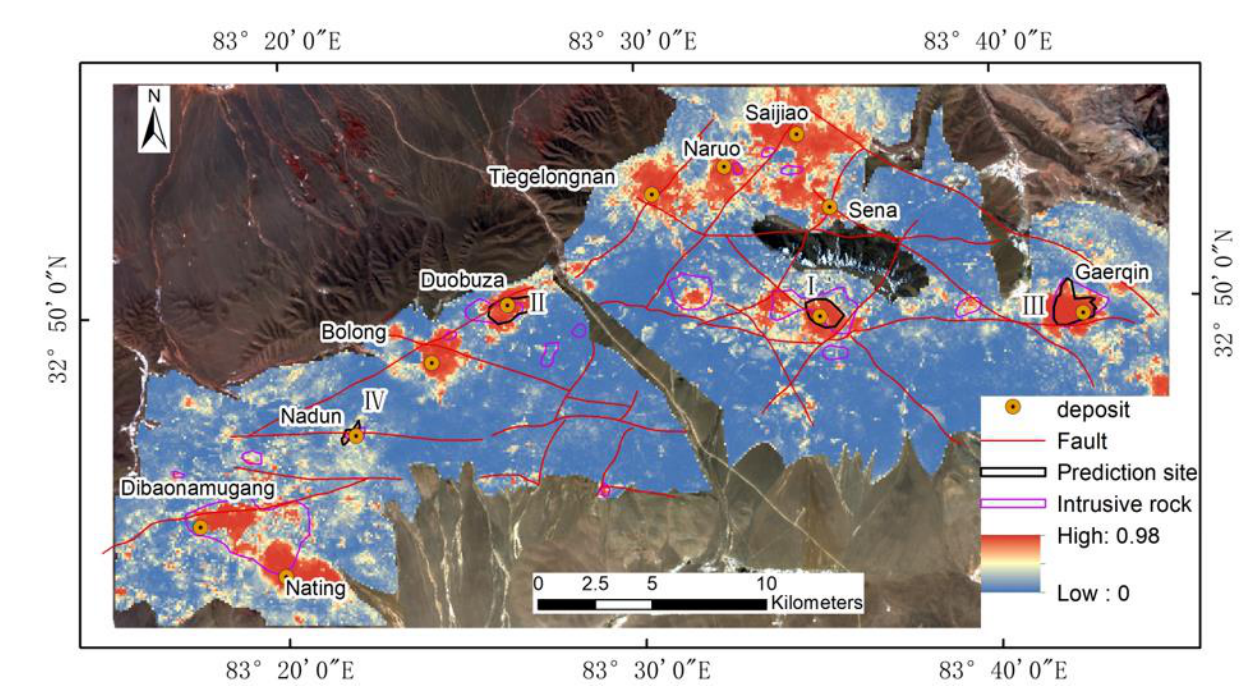
Figure 16. Prospectivity maps showing different potential areas delineated by the black line.